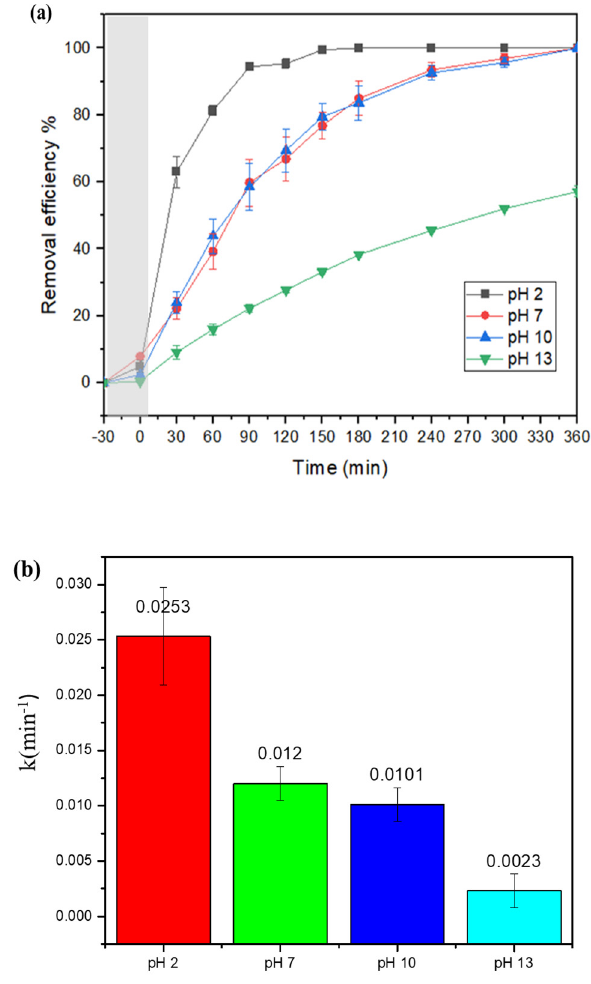
Figure 2. Degradation of CBZ in solutions of different pH: ( a ) Removal efficiency; ( b ) kinetic degra- dation.